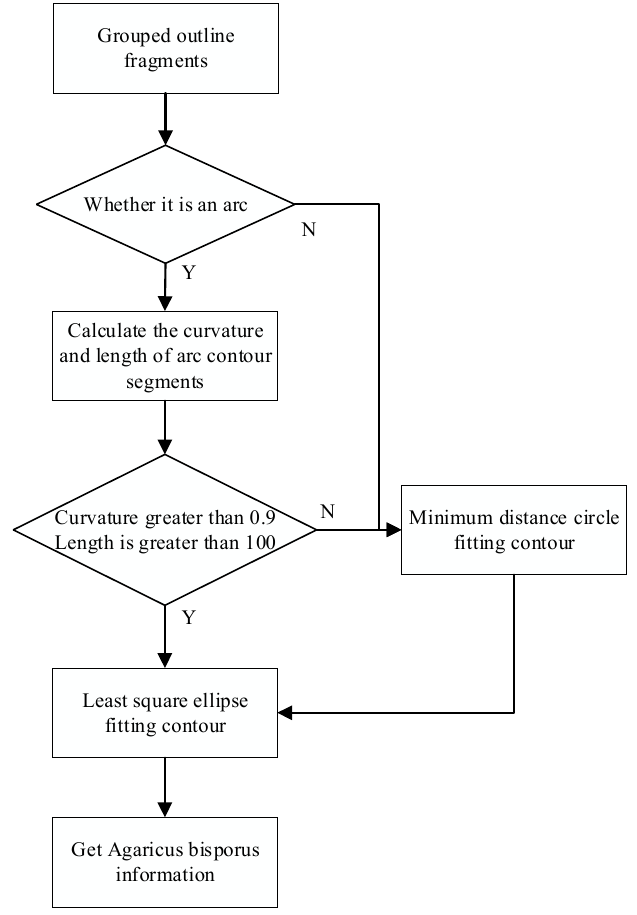
Figure 13. Flow chart of reconstruction contour.